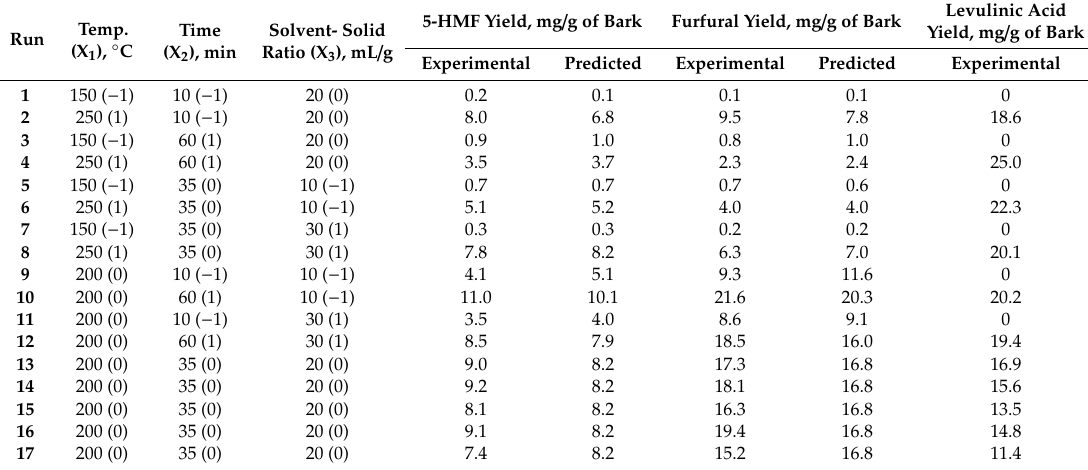
Table 10. Proposed experiments by Box-Behnken method and the predicted and experimental values of sugar derivatives obtained by subcritical water extraction of chestnut